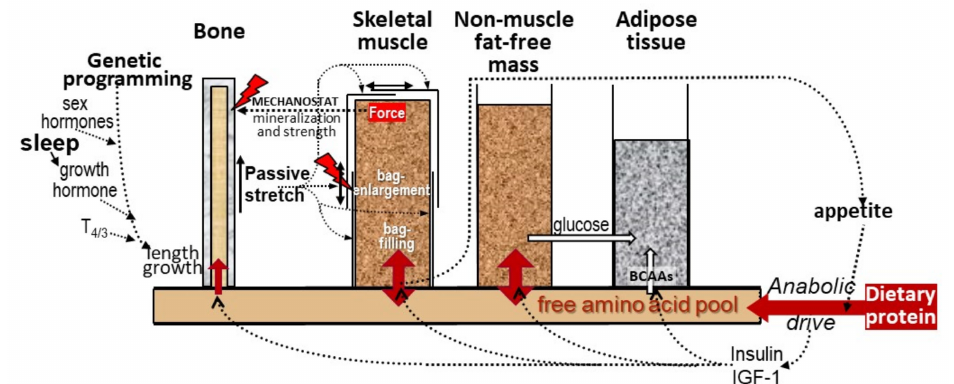
Figure 16. The Protein-Stat, (updated from Millward 1995 [7]). Whole-body protein content is controlled through an amino-static appetite mechanism, acting primarily to maintain skeletal-muscle mass at a level set by the linear dimensions of the organism. Bone lengthening occurs at rates determined by genetic programming (canalisation) mediated by growth hormone, secretion of which is primarily sleep-dependent, by thyroid hormones and by the sex steroids during puberty, acting together with an appropriate anabolic drive deriving from dietary protein. This anabolic drive, both permissive and active, is mediated by amino acids, insulin, IGF-1 (and in the rat T3) and other important nutrients like zinc and vitamin D, and provides the regulatory stimulus for protein deposition in all tissues. Net protein deposition during skeletal muscle growth occurs within myofibres which are limited in volume by the extracellular matrix of connective tissue which surrounds individual and groups of myofibres as well as the whole muscle (see Figure 3), like concentric “bags”. Thus, increased myofibre diameter and length during muscle growth requires remodelling of the muscle ECM to enable “bag” enlargement which is mediated by the passive stretching of skeletal muscle subsequent to bone length growth, activating satellite cells and other associated cells through mechanotransduction mechanisms. The linkage of bone length to muscle mass allows muscle size to be regulated at a genotypic muscle weight–bone length ratio. Increasing muscle size and force generation acts via the mechanostat to increase bone mineralisation and strength commensurate with muscle mass. Any dietary protein-derived amino acid intake in excess of that required for maximal “bag filling” will either expand the non-muscle lean body mass or be oxidized with the carbon skeletons leaving the liver as ketones and glucose, the latter to be taken up in adipose tissue for lipogenesis. Also excess branched chain amino acids can be taken up directly by adipose tissue and converted to fat. This metabolic fate of excess protein as adipogenesis is part of the Early Protein Hypothesis in which excess protein intake in infancy programmes